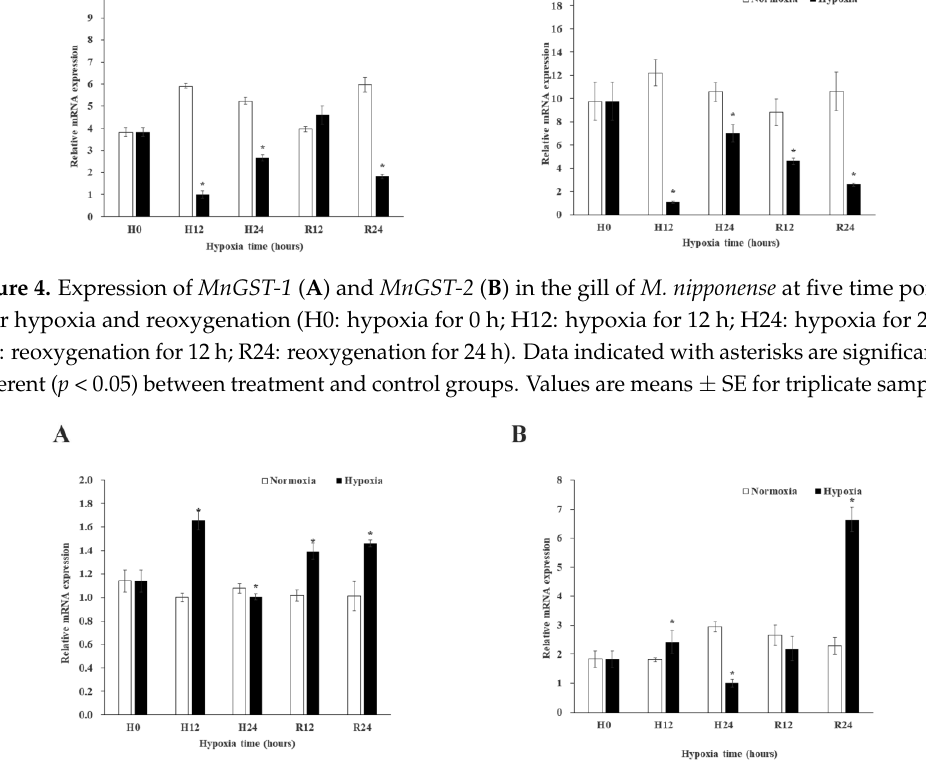
Figure 5. Expression of MnGST-1 ( A ) and MnGST-2 ( B ) in the muscle of M. nipponense at five time points after hypoxia and reoxygenation (H0: hypoxia for 0 h; H12: hypoxia for 12 h; H24: hypoxia for 24 h; R12: reoxygenation for 12 h; R24: reoxygenation for 24 h). Data indicated with asterisks are significantly different ( p < 0.05) between treatment and control groups. Values are means ± SE for triplicate samples.